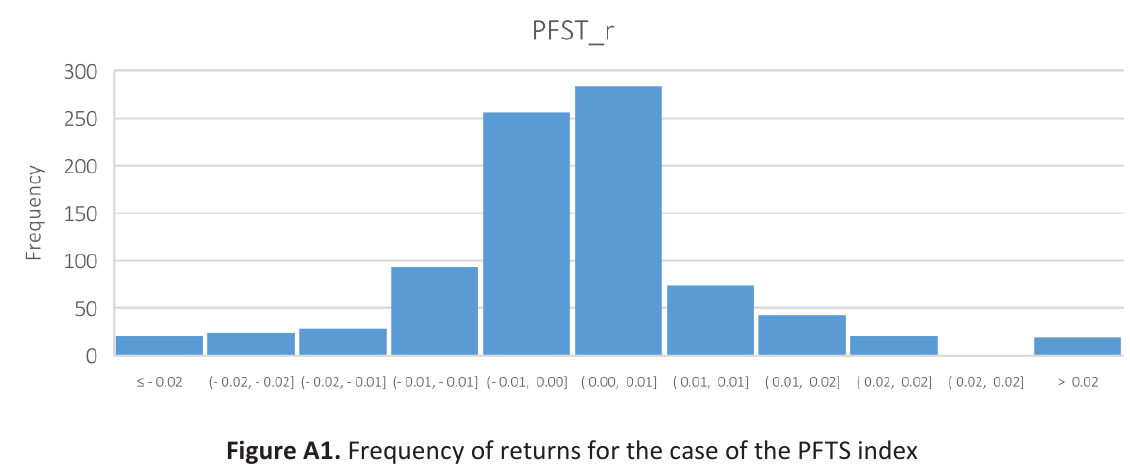
Figure A1. Frequency of returns for the case of the PFTS index